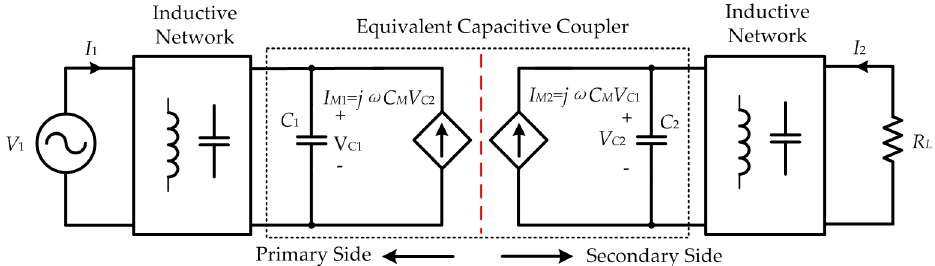
Figure 9. Equivalent circuit topology of a CPT system with inductive networks.